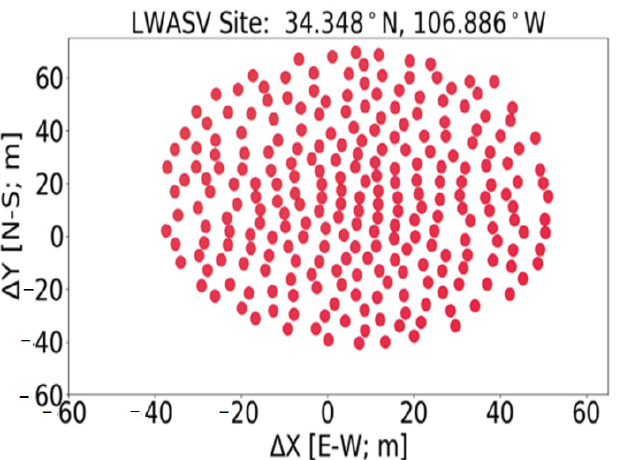
Figure 2. Antenna locations of LWA − SV which show the position of each antenna as a red circle in x and y direction.